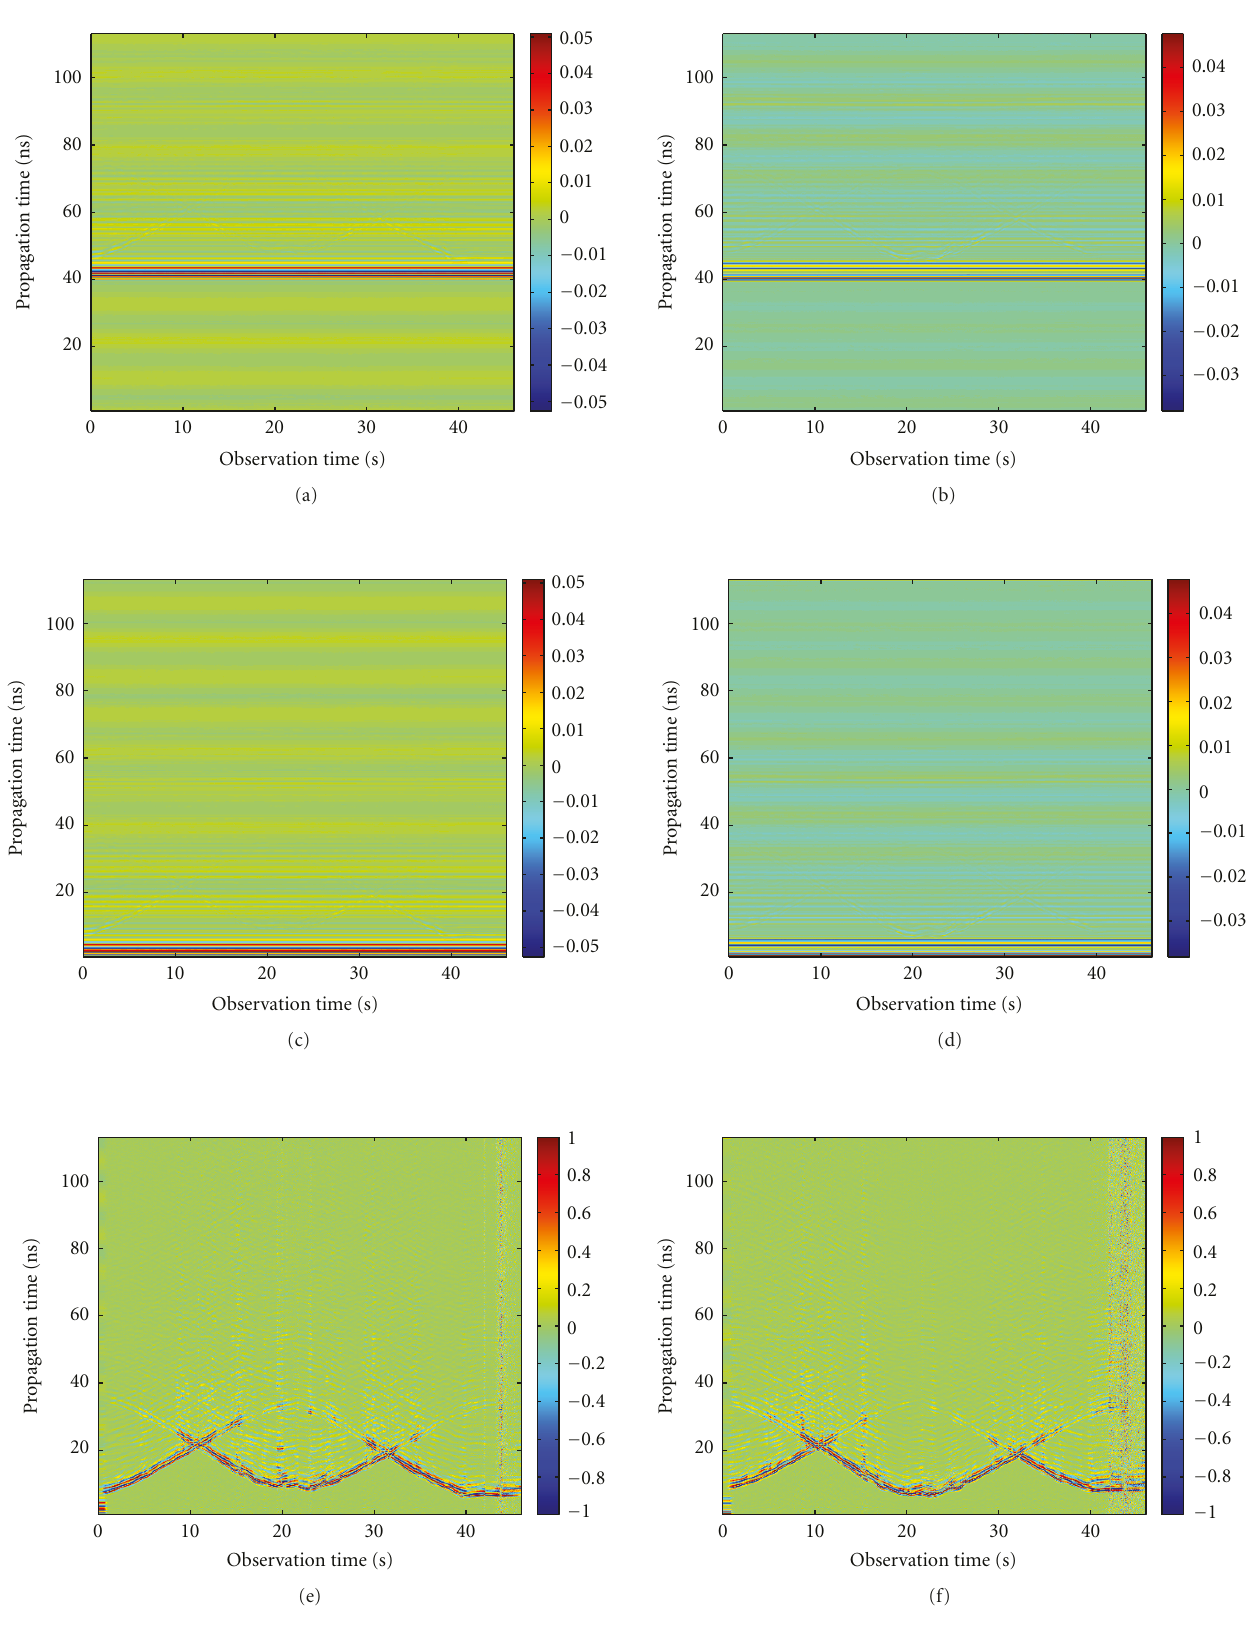
Figure 5: Raw radar signals: (a) radargram for Rx 1 , (b) radargram for Rx 2 ; preprocessed signals: (c) radargram for Rx 1 , (d) radargram for Rx 2 ; signals with subtracted background: (e) radargram for